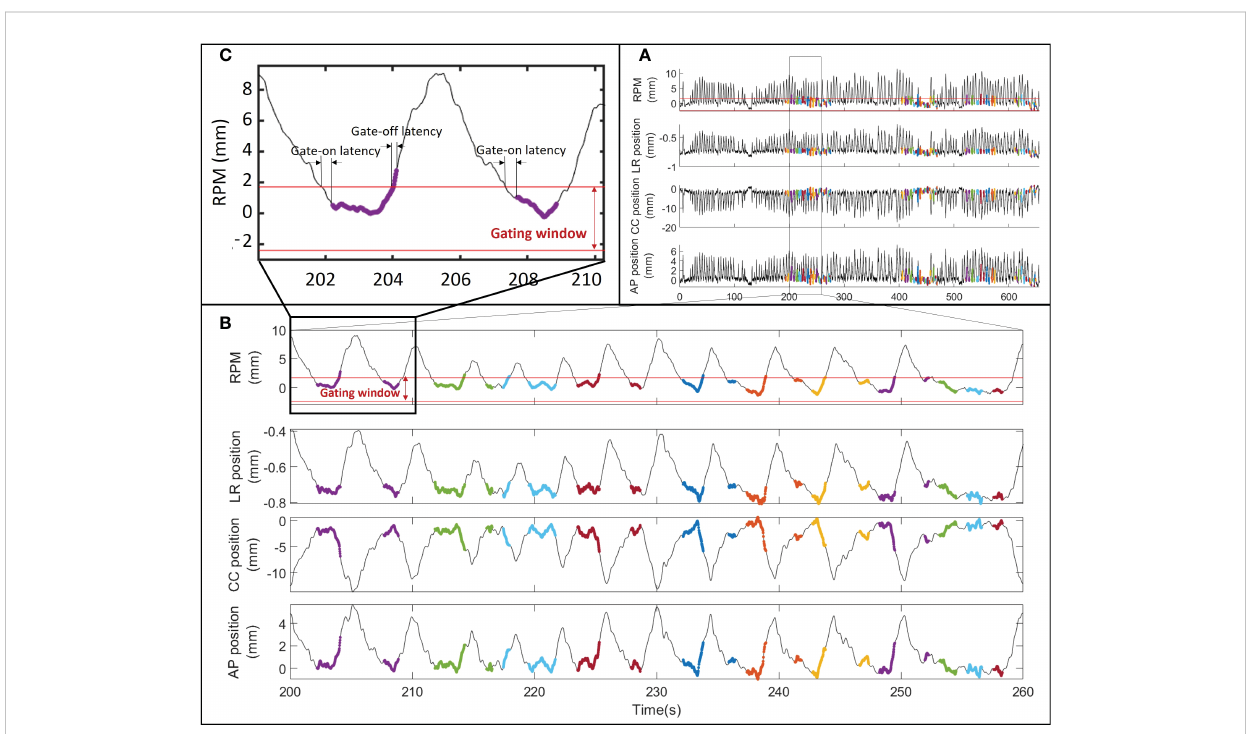
FIGURE 4 RPM signal and estimated internal tumor motion for fraction 1 of patient 3 during (A) the entire fraction, (B) a single fi eld and (C) two breathing cycles. The thick colored curves show the spot delivery times with different energy layers indicated with different colors. The gating window and the gate-on and gate-off latencies are shown for the RPM signal.